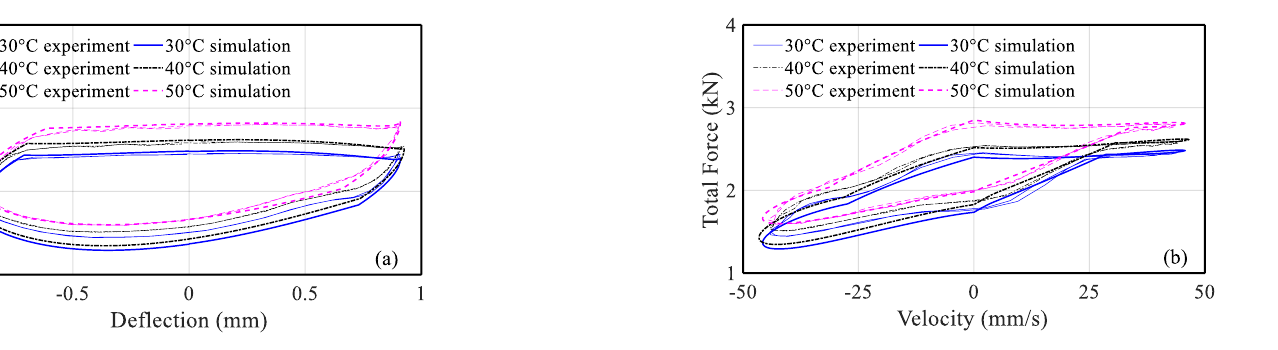
Figure 6. Comparisons of experimental and simulated total force-deflection ( a ) and total force-velocity ( b ) relationships at different temperatures (8 Hz).